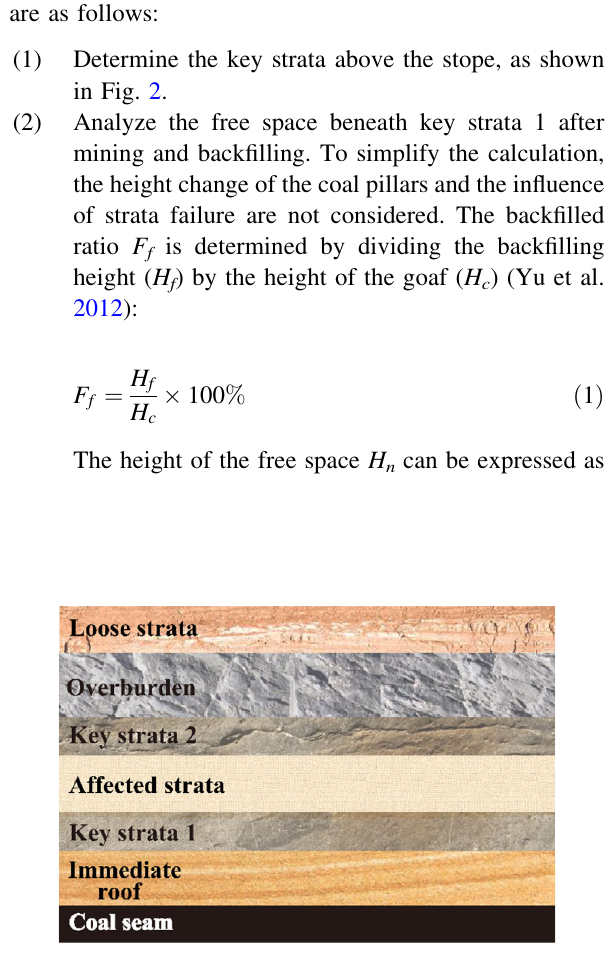
Fig. 1 Failure patterns of the overburden during backfill mining Fig. 2 Diagram of the locations of key